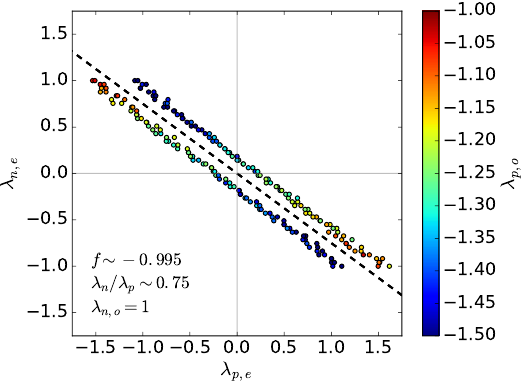
Figure 6 . Relationship between Lagrangian couplings and observable parameters f , (cid:21) p and (cid:21) n . Random sample of points in the parameter space (cid:21) p;e , (cid:21) p;o , (cid:21) n;e , (cid:21) n;o (see eq. (2.1)) which satisfy f 2 [ (cid:0) 0 : 99 ; (cid:0) 1] and (cid:21) n =(cid:21) p 2 [0 : 7 ; 0 : 8] (see eqs. (2.4){(2.6)). The points shown here therefore correspond to a region of parameter space where discrimination between Dirac and Majorana DM is most promising. We (cid:12)x (cid:21) n;o = 1 (which simply (cid:12)xes the overall normalisation of the couplings) and color each point by the value of (cid:21) p;o . The dashed diagonal line corresponds to (cid:21) n;e =(cid:21) p;e = 0 : 75.